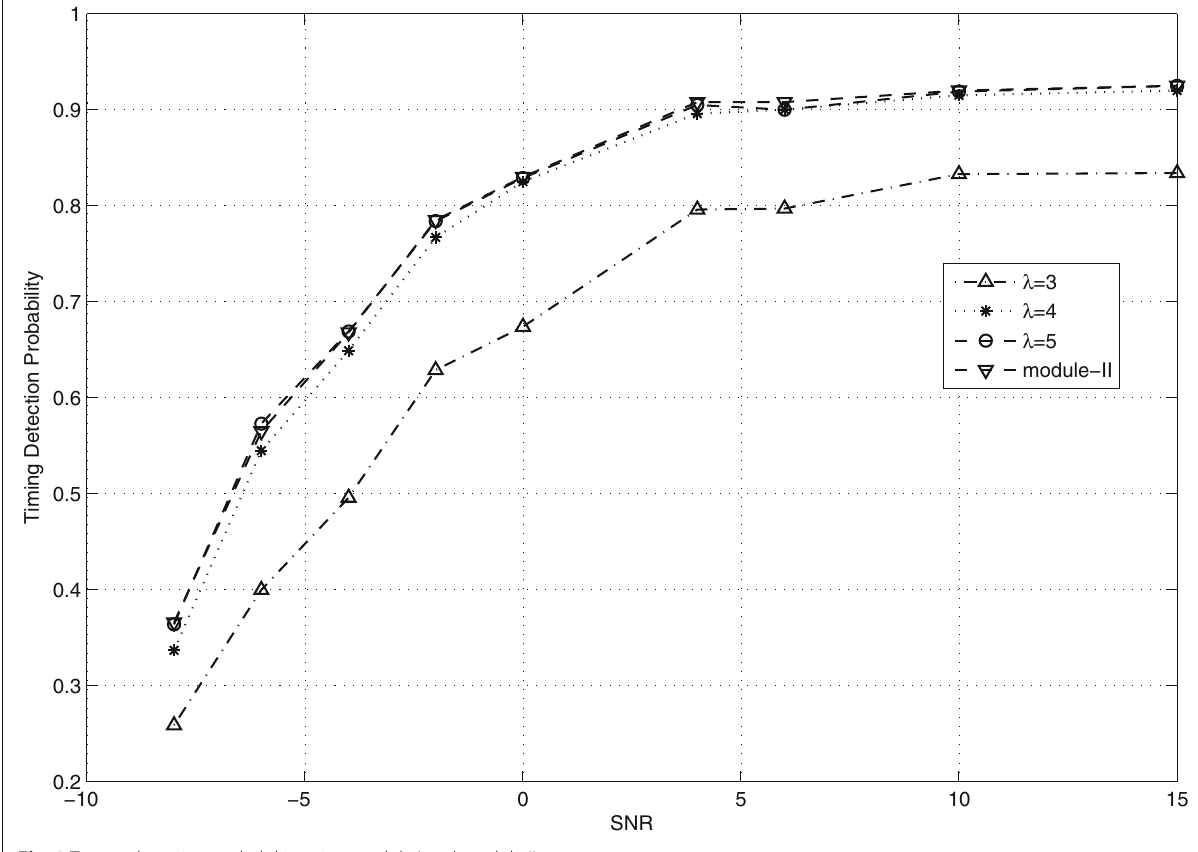
Fig. 8 Timing detection probability using module I and module